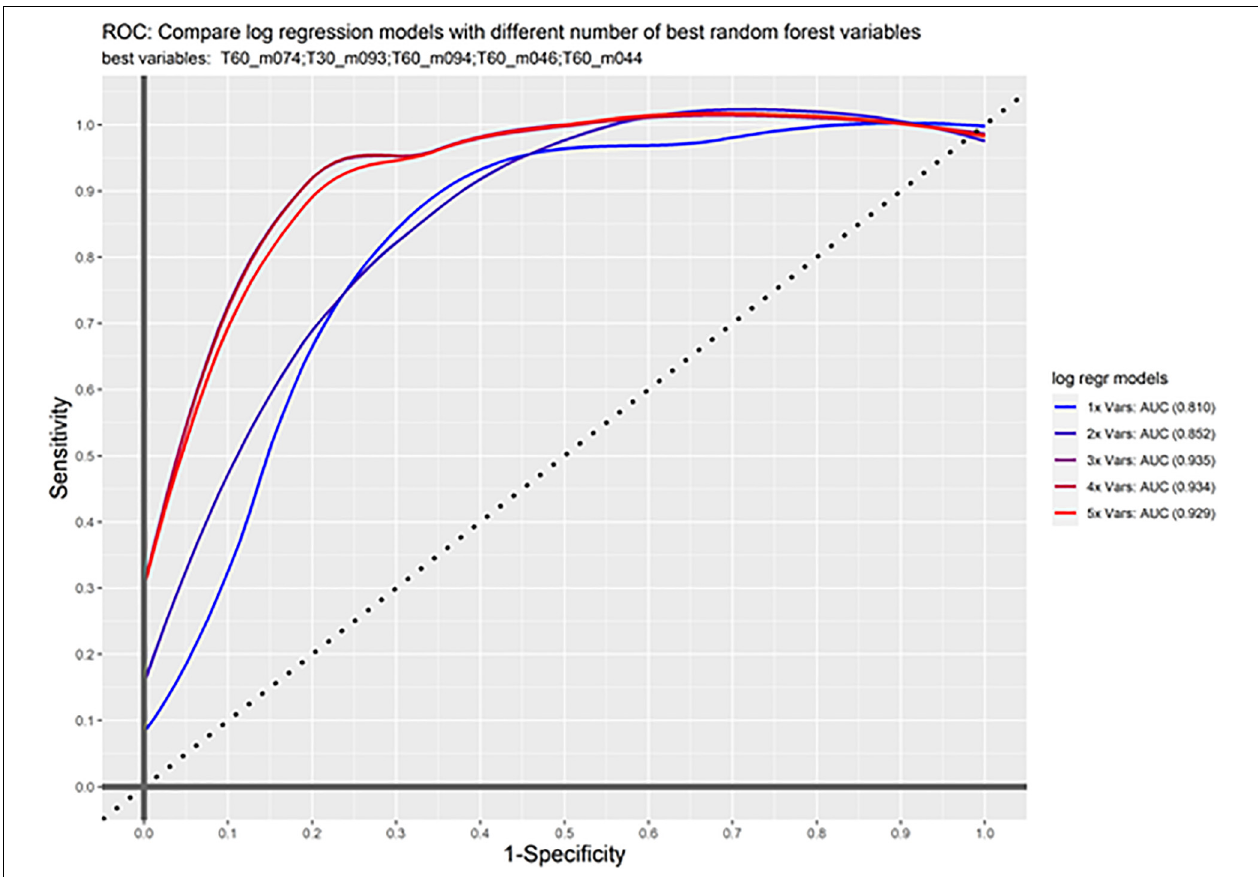
FIGURE 3 | ROC curve. Shown is sensitivity and 1-specificity for the combination of markers in the validation sample. First m/z 74 was calculated alone (1x Vars), then subsequently the other important markers are added showing an increase up to the first three